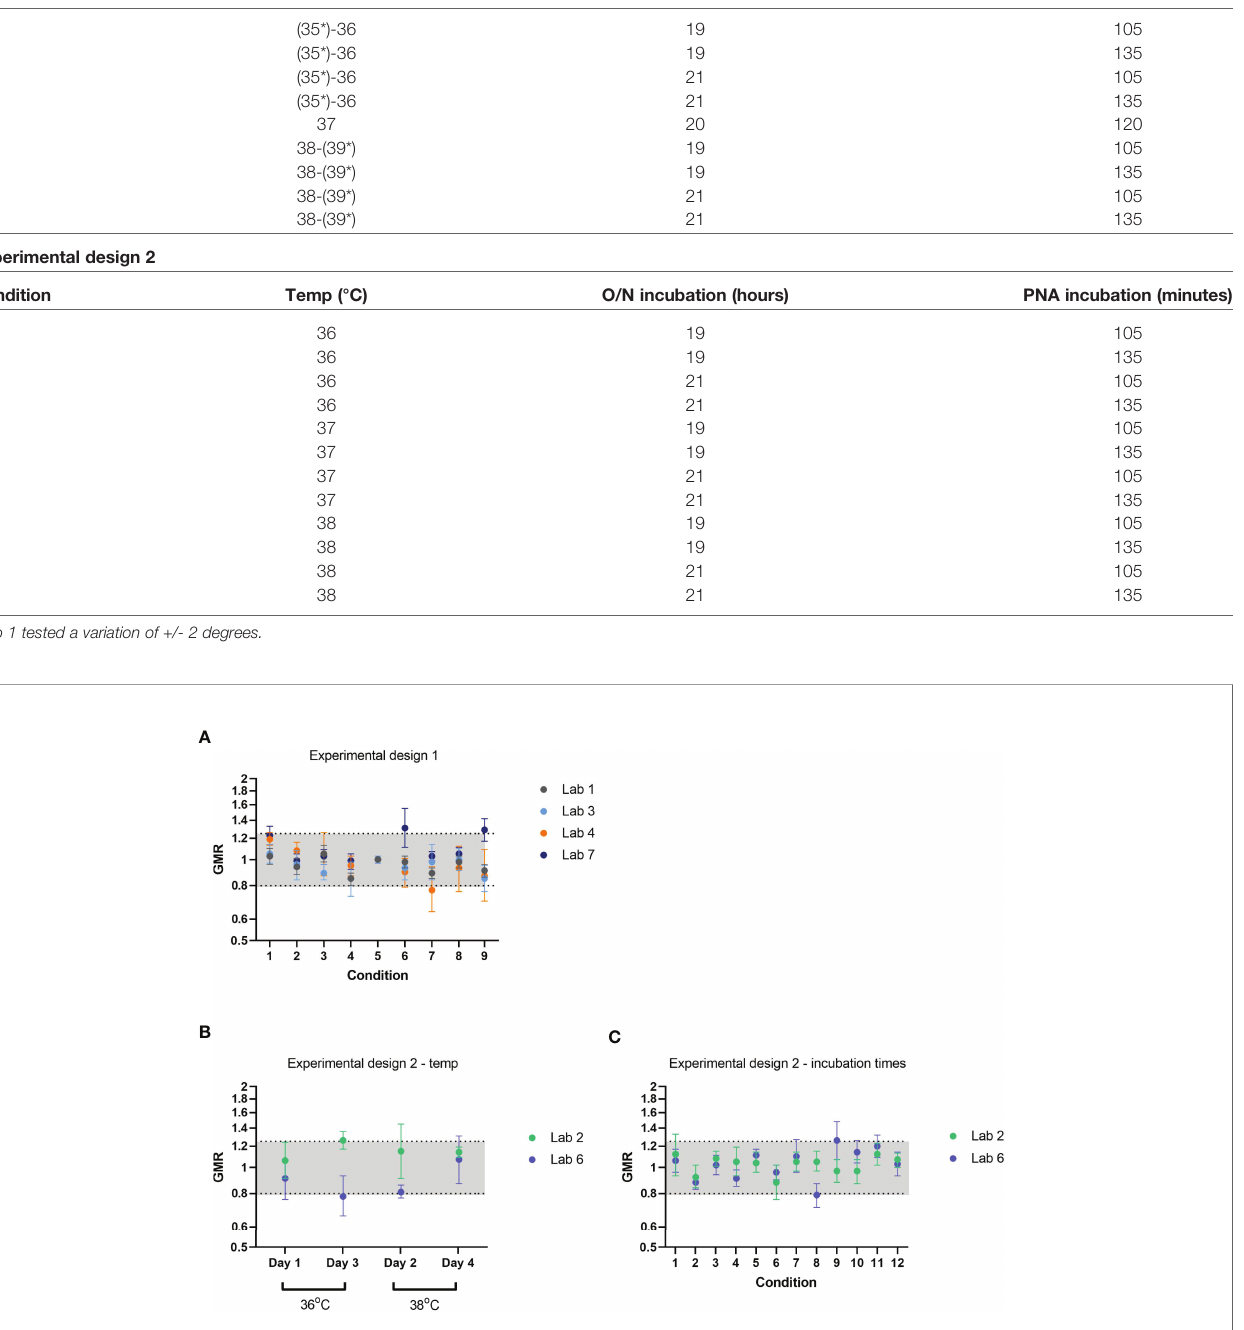
FIGURE 3 | Robustness of FLUCOP ELLA-NI SOP; varying incubation time and temperature. Geometric mean ratios (GMR) per condition across 12 samples are plotted for each testing laboratory. Conditions tested are varying combinations of virus incubation temperature (37°C +/- 1 degree ─ or +/- 2 degrees for Lab 1), virus incubation time (20h +/- 1h) and PNA incubation time (105/120/135 minutes) according to a design of experiment (see Table 4 ). Two experimental designs were carried out based on the laboratories ’ ability to test multiple temperatures in a single ELLA run (A) or a single temperature per run (B, C) . Different statistical analysis approaches were used for the different designs to allow for day effect and confounding factors. GMRs were calculated relative to an appropriate reference value for each sample, for each design, as described in materials and methods. Upper and lower 95% CI are shown as error bars. The indicative range of 0.8-1.25 is shaded in light grey.